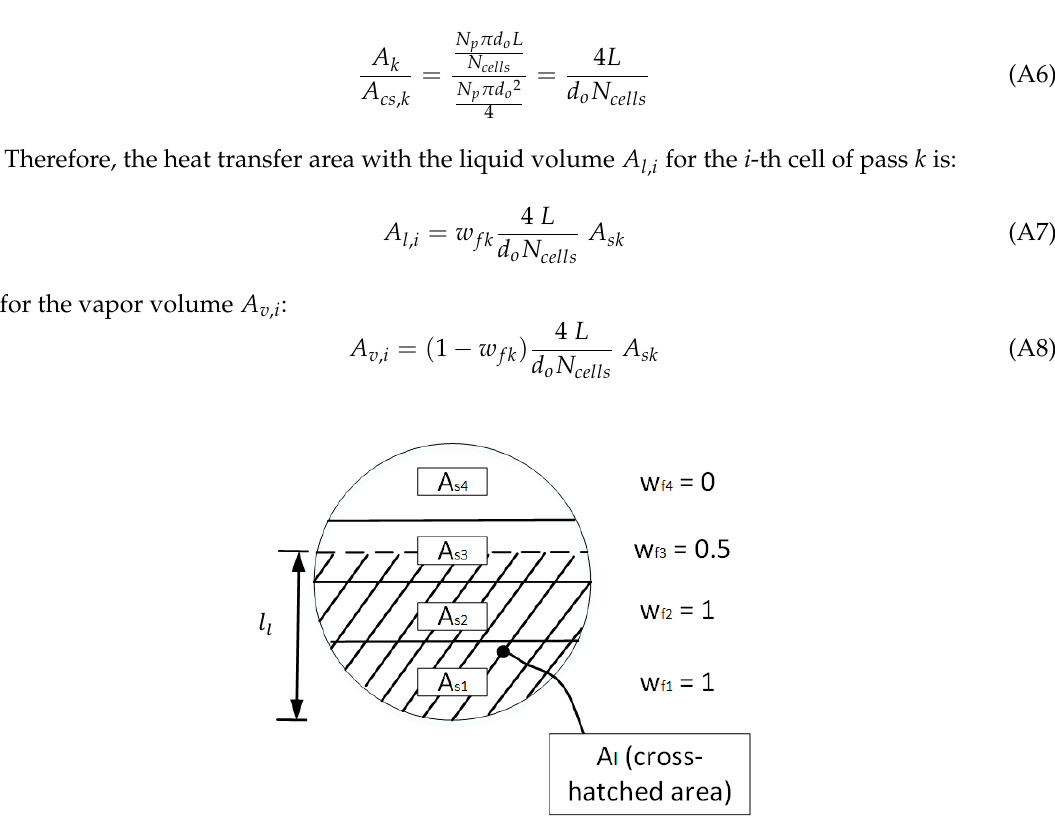
Figure A1. Cross-sectional areas and area fractions as a function of the liquid level (all areas here shown refer to only the cross-sectional area of the pipes).